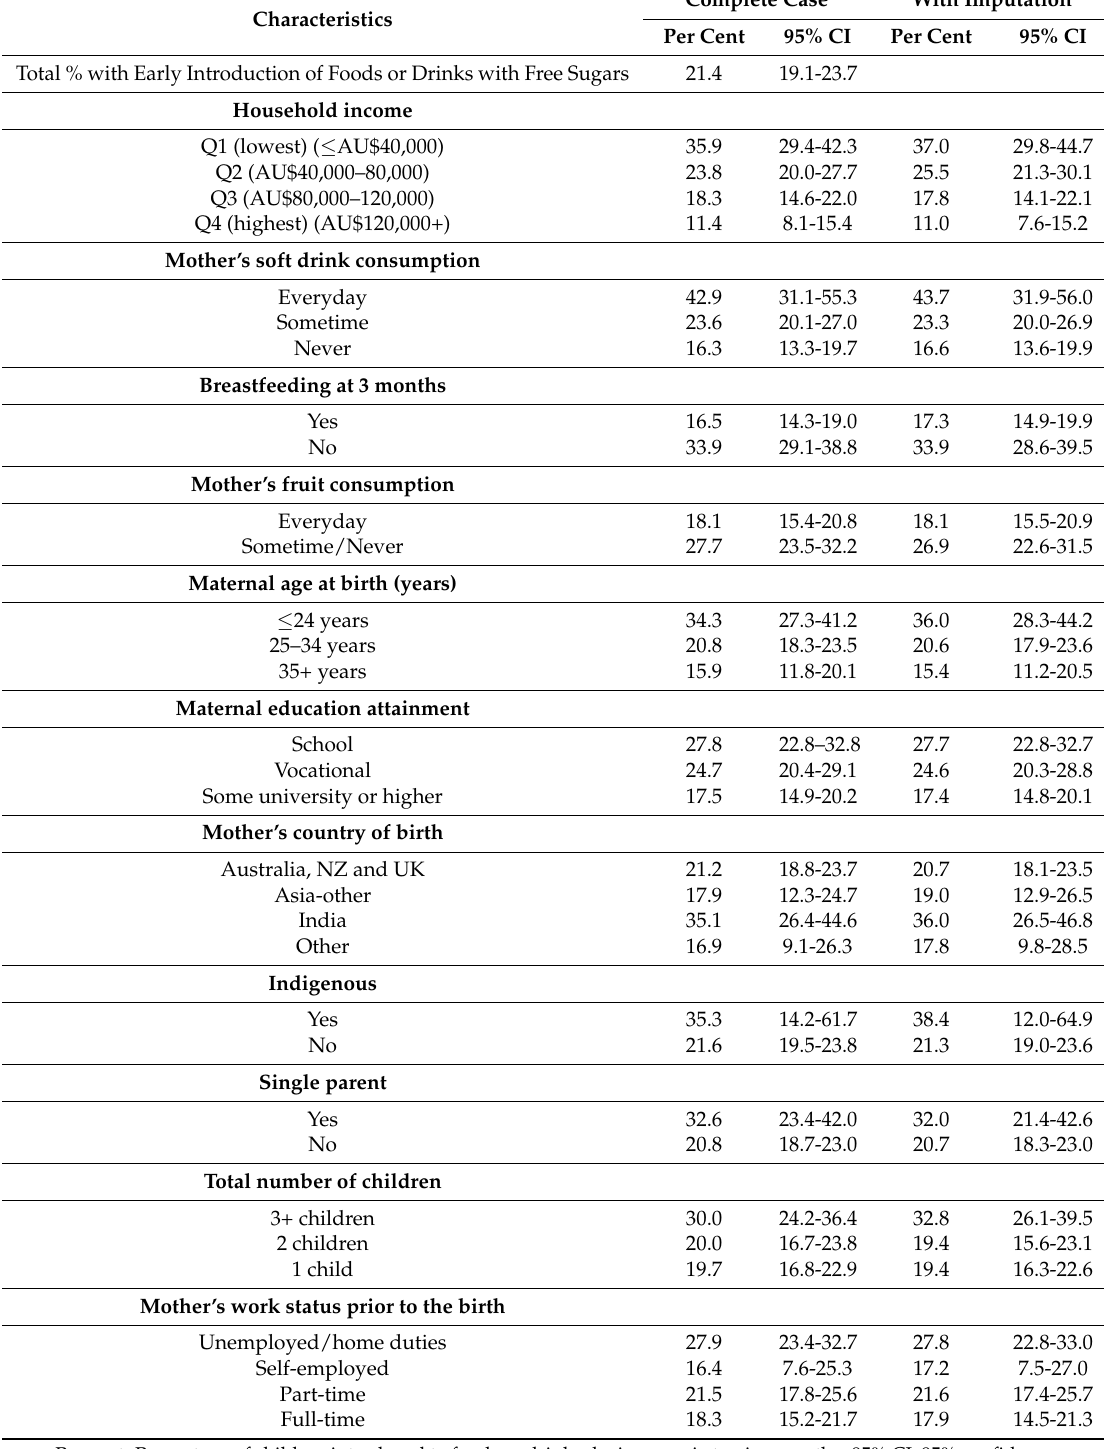
Table 2. Percentage of children who experienced early introduction of foods or drinks with free sugars, by socioeconomic status (SES) and other covariates. Complete Case With Imputation Characteristics Per Cent 95% CI Per Cent 95%